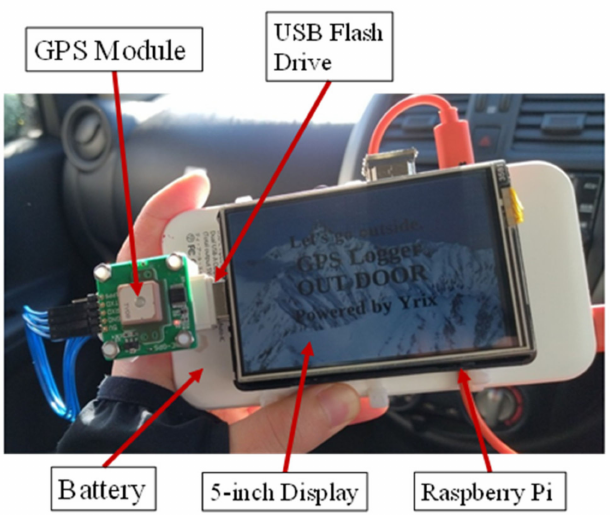
Figure 3. GPS logger that we developed and used in this